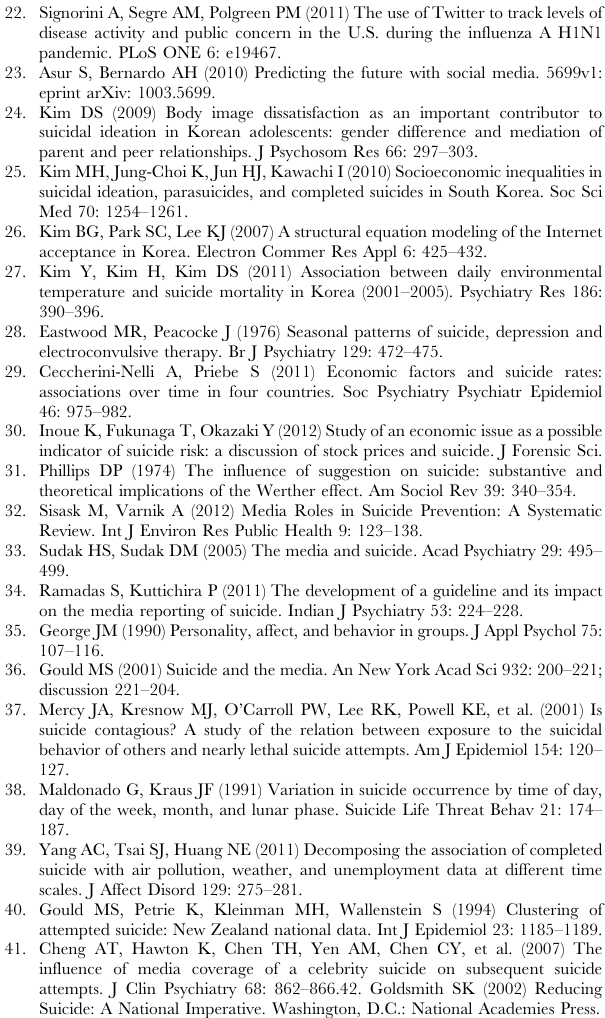
Figure A Trend of annual national suicide numbers per 100,000 persons in Korea, 1991–2010. ( ) Text S1 Table A. Univariate regression analyses between individual variables and number of suicides at a prediction time point.